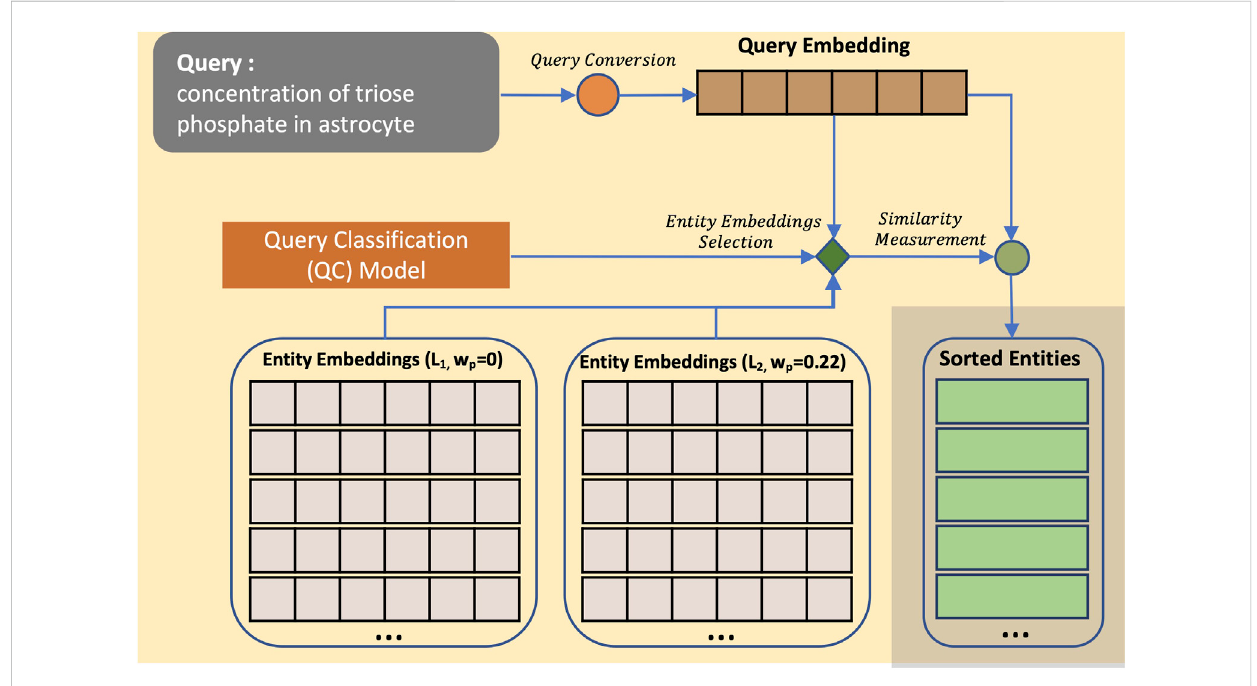
FIGURE 4 Entitysearch processusingCASBERT. CASBERTprovidesentityembeddingliststochoose fromintheretrievalprocessaccordingto thequerytype. Lists are distinguished by different w p values, for example, L 1 with avalueof 0and L 2 with a valueof 0.22. At fi rst, thequeryis converted to an embedding. Then, the embedding becomes the input of the Query Classi fi er (QC) model to select the correct entity embedding list. The entity results are then taken from the chosen entity embedding list and presented in a sorted order based on cosine similarity